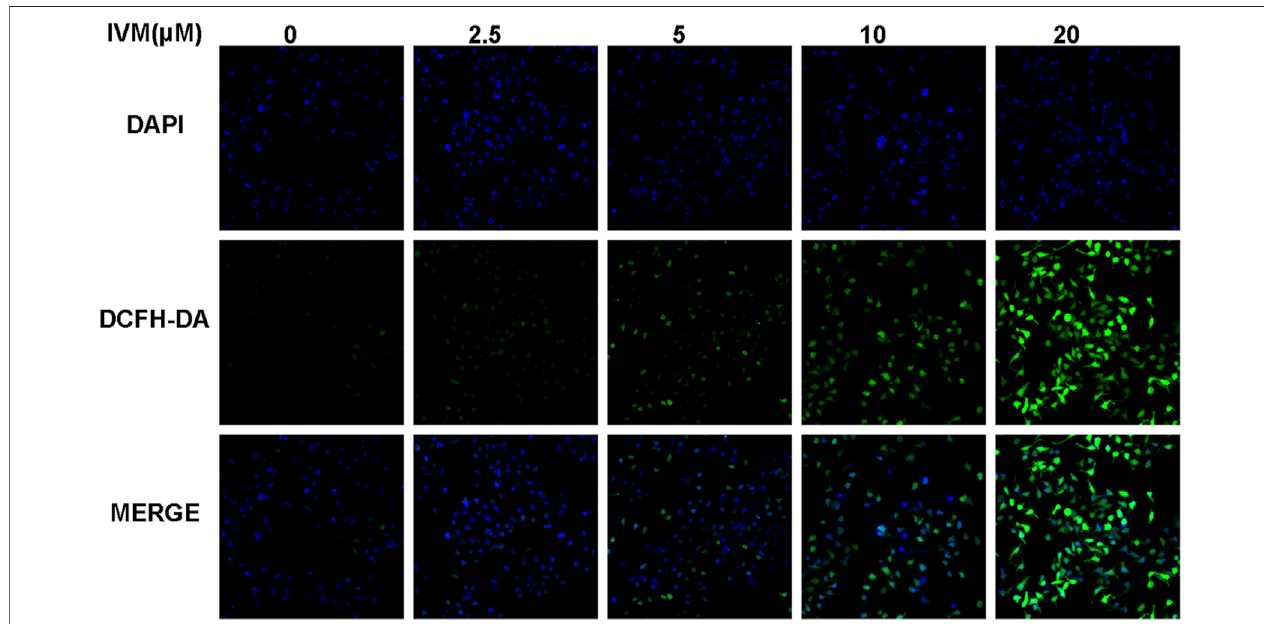
FIGURE7 | Ivermectin increased total intracellular ROS generationin SW1116 cells. SW1116 cells were treated with ivermectin at the indicated concentrations (0, 2.5, 5, 10, and 20 μ M) for 6 h. Then the cells were co-stained by DCFH-DA and DAPI, described as the “ Materials and Methods ” section; cells were visualized using a fl uorescence microscope. Representative images were shown, and the experiment was repeated three times. IVM, ivermectin.